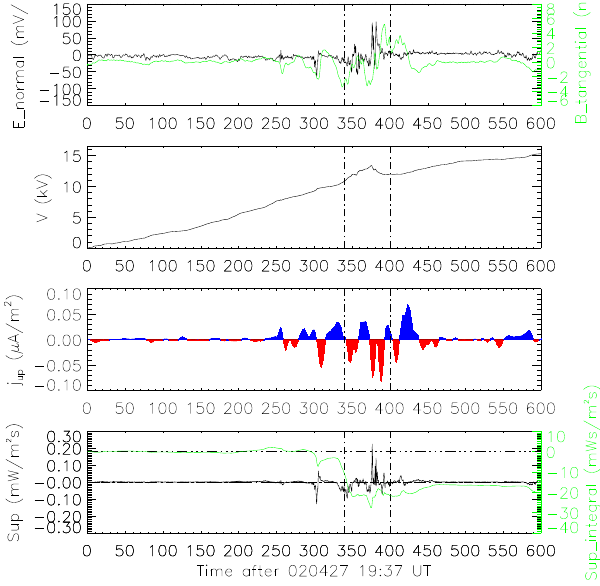
Fig. 9. 27 April 2002, s/c 2. The same panels as in Fig. 2 but without PEACE electron